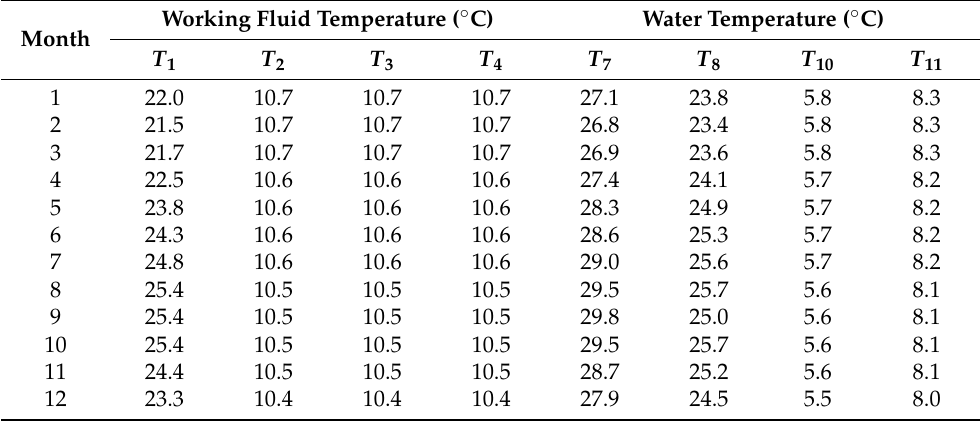
Table A4. Inlet and outlet temperature for maximum power output, using GWR-TMCAS temperature data and minimum working fluid